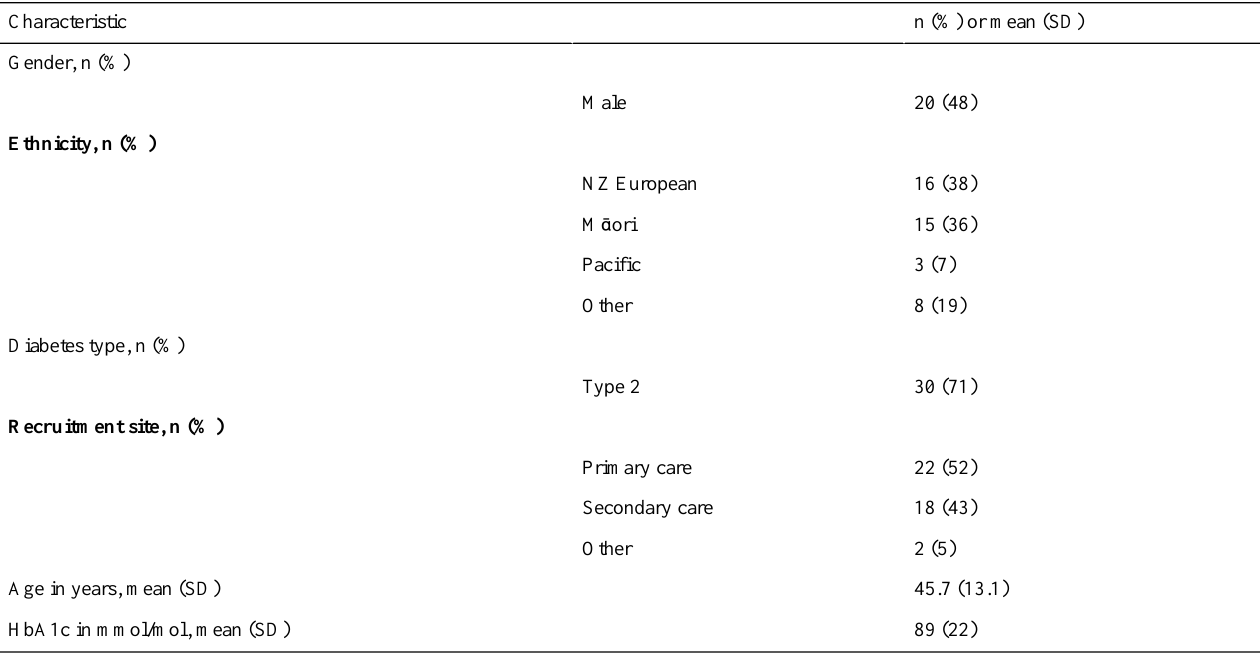
Table 2. Participant characteristics (n=42).